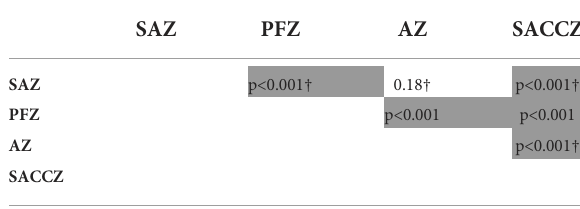
TABLE 2 Inter-annual variability per zone: p-values from the t-tests conducted on the F v /F m per cruise in each zone ( Figure 3 ). (a)